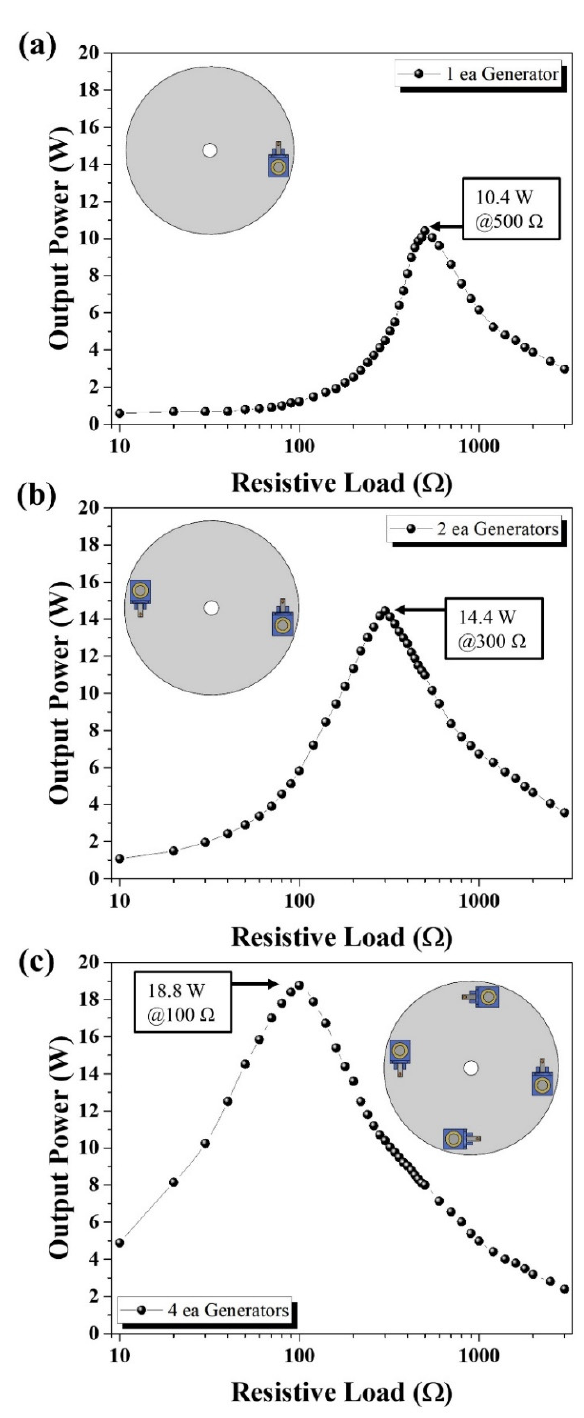
Figure 9. Plots of resistive load-dependent output power provided by primary impact for hammer- impact-driven power generator array at impeller rotation speed of 250 RPM, with various numbers of power generators. ( a ) one generator; ( b ) two generators; ( c ) four generators.